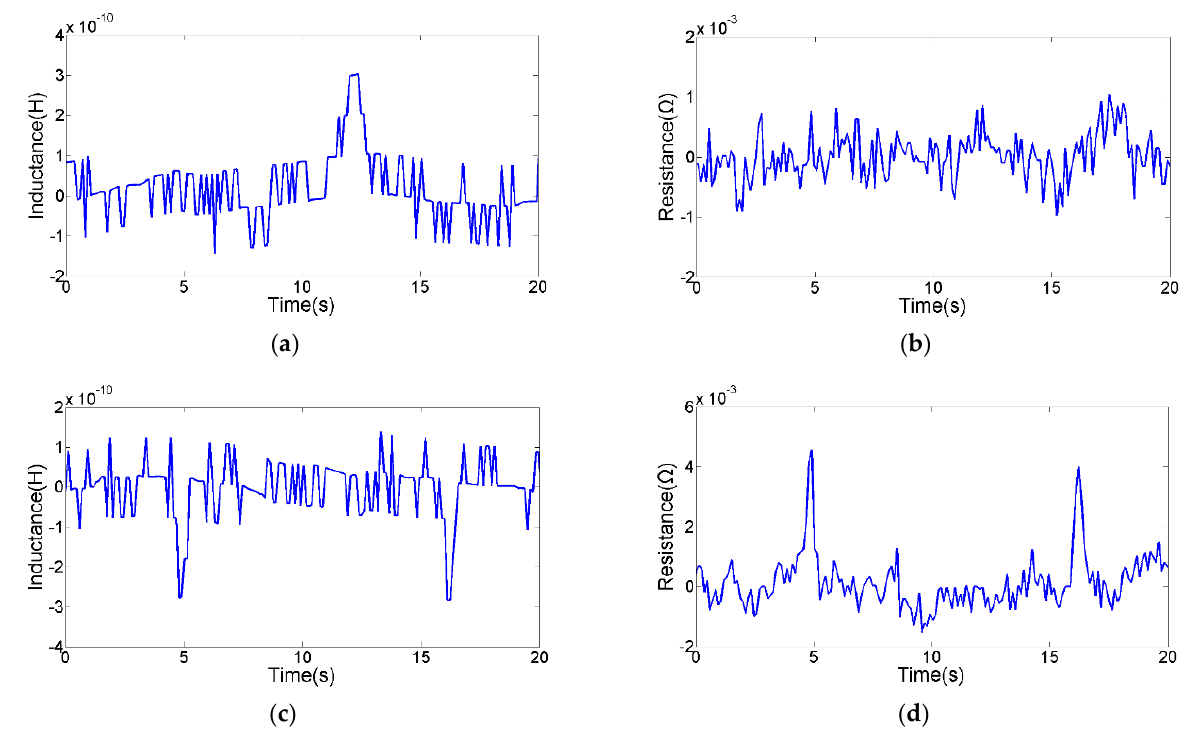
Figure 10. The detection floor level of inductance parameter. ( a ) The inductance signal of 28 μm iron debris, ( b ) the resistance signal of 28 μm iron debris, ( c ) the inductance signal of 85 μm copper debris, ( d ) the resistance signal of 85 μm copper debris.